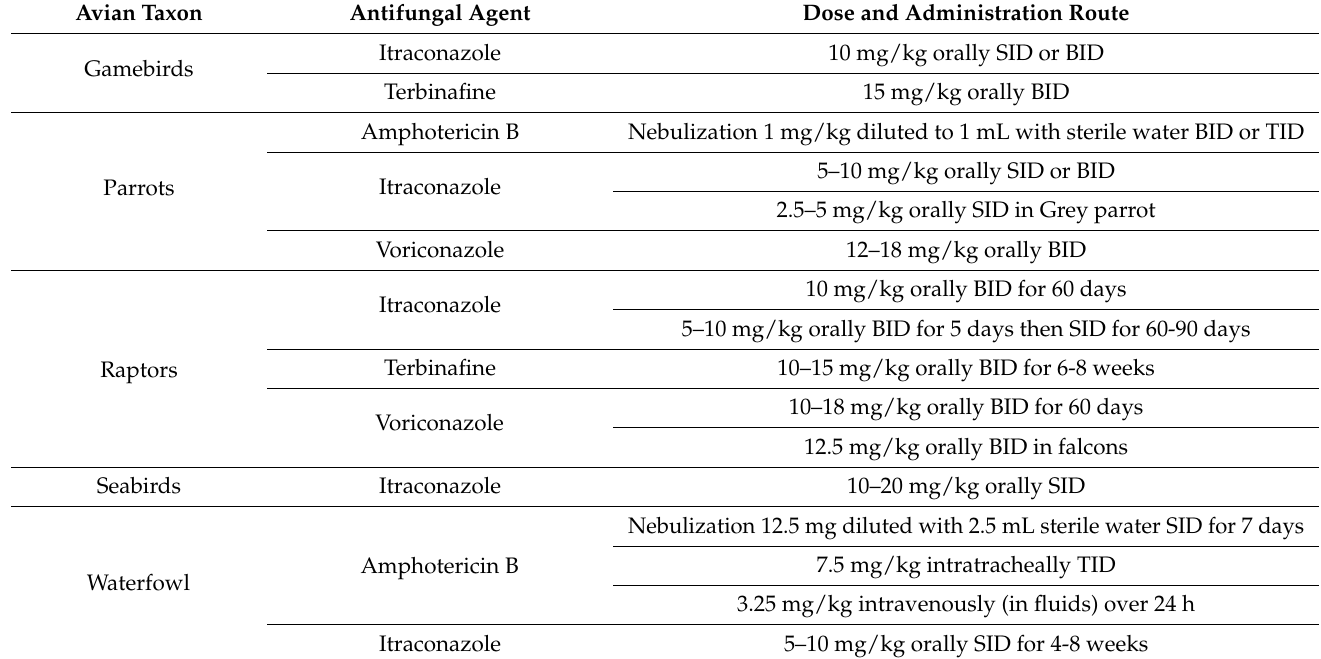
Table 4. Antifungal treatments recommended for avian aspergillosis